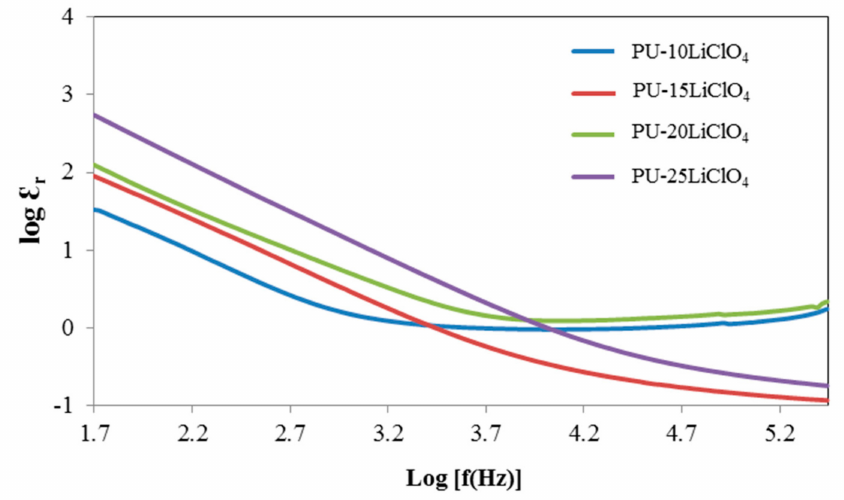
Figure 13. Dielectric constant against log frequency of PU having 10 wt.% to 25 wt.% LiClO 4 .